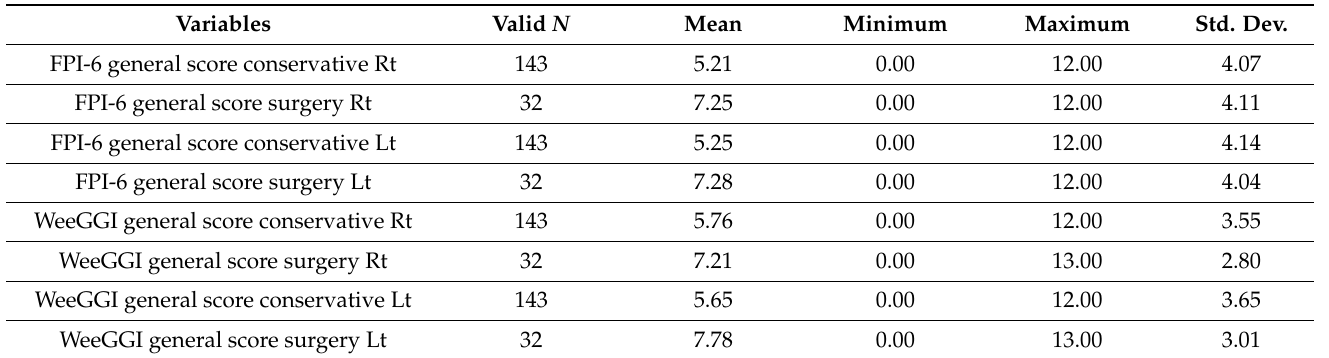
Table 2. Foot and gait analysis results for the conservative treatment and surgery